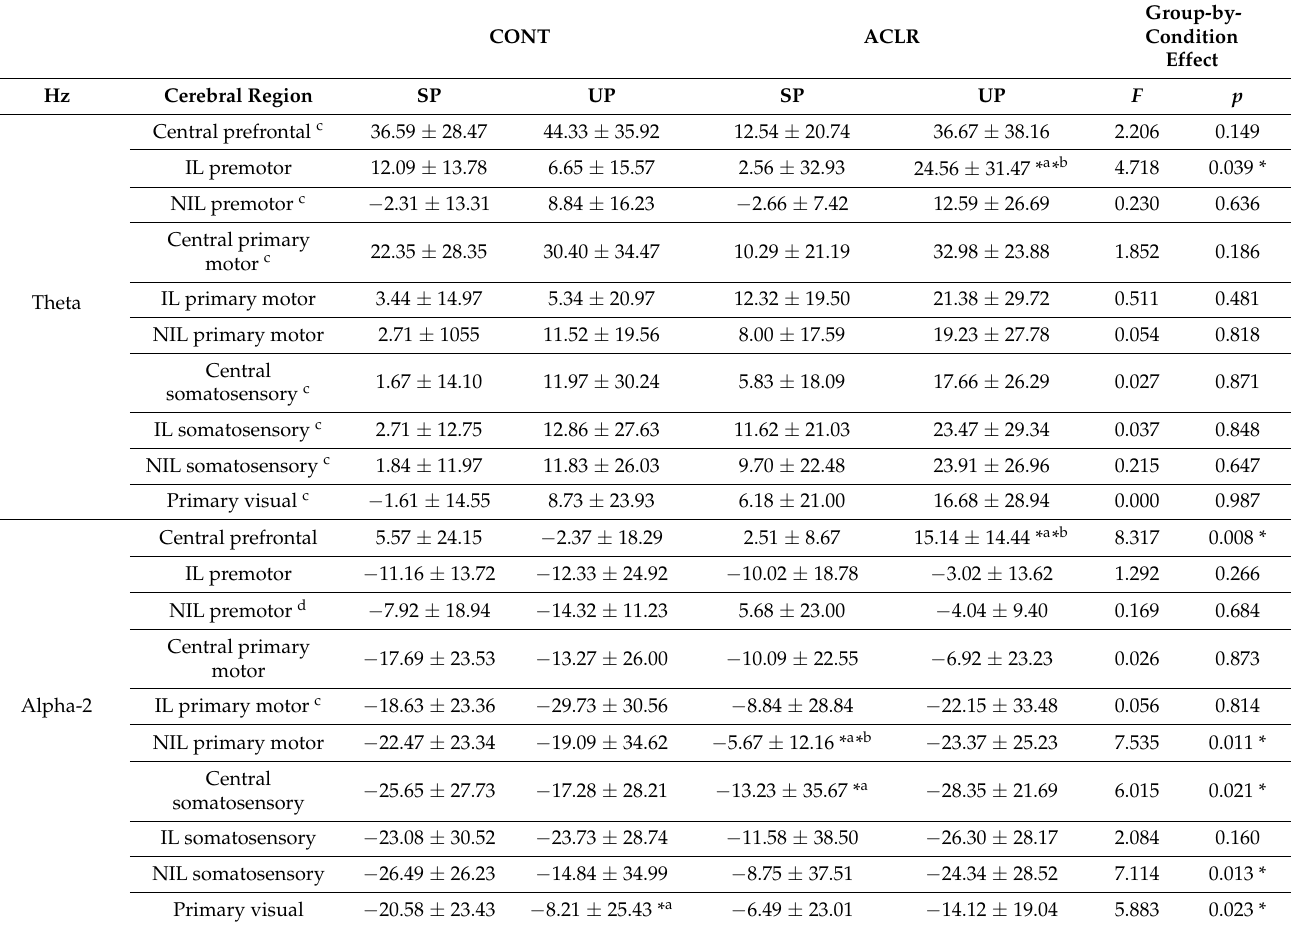
Table 2. Significant different electrocortical activation patterns were observed between groups during the single-leg stance tasks. CONT ACLR